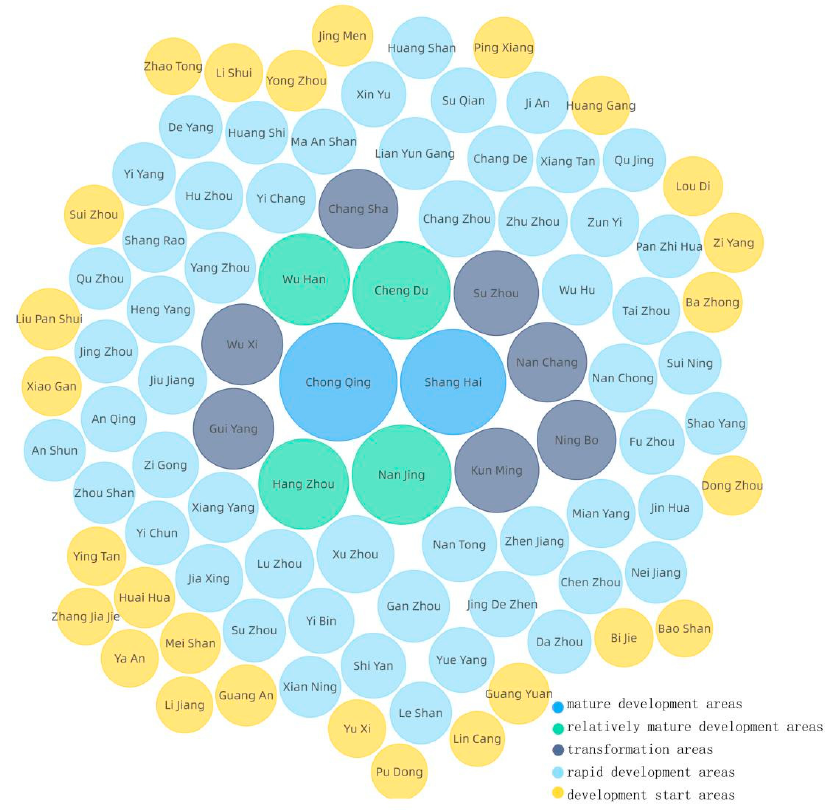
Figure 11. Classification of urban green space construction status.